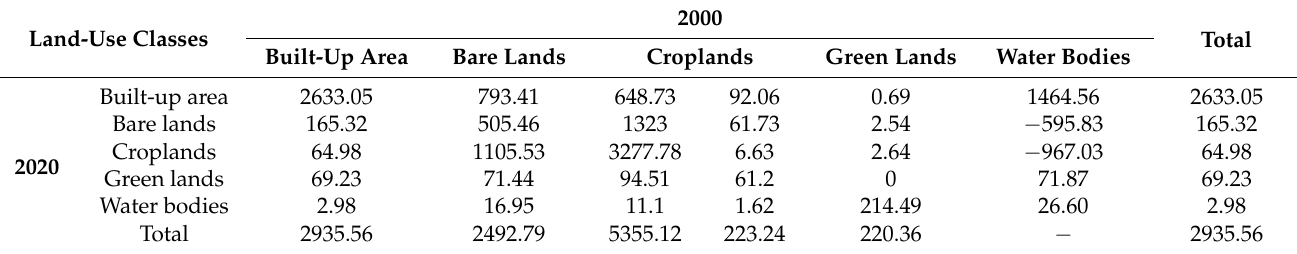
Table 4. Matrix of land-use class changes from 2000 to 2020.